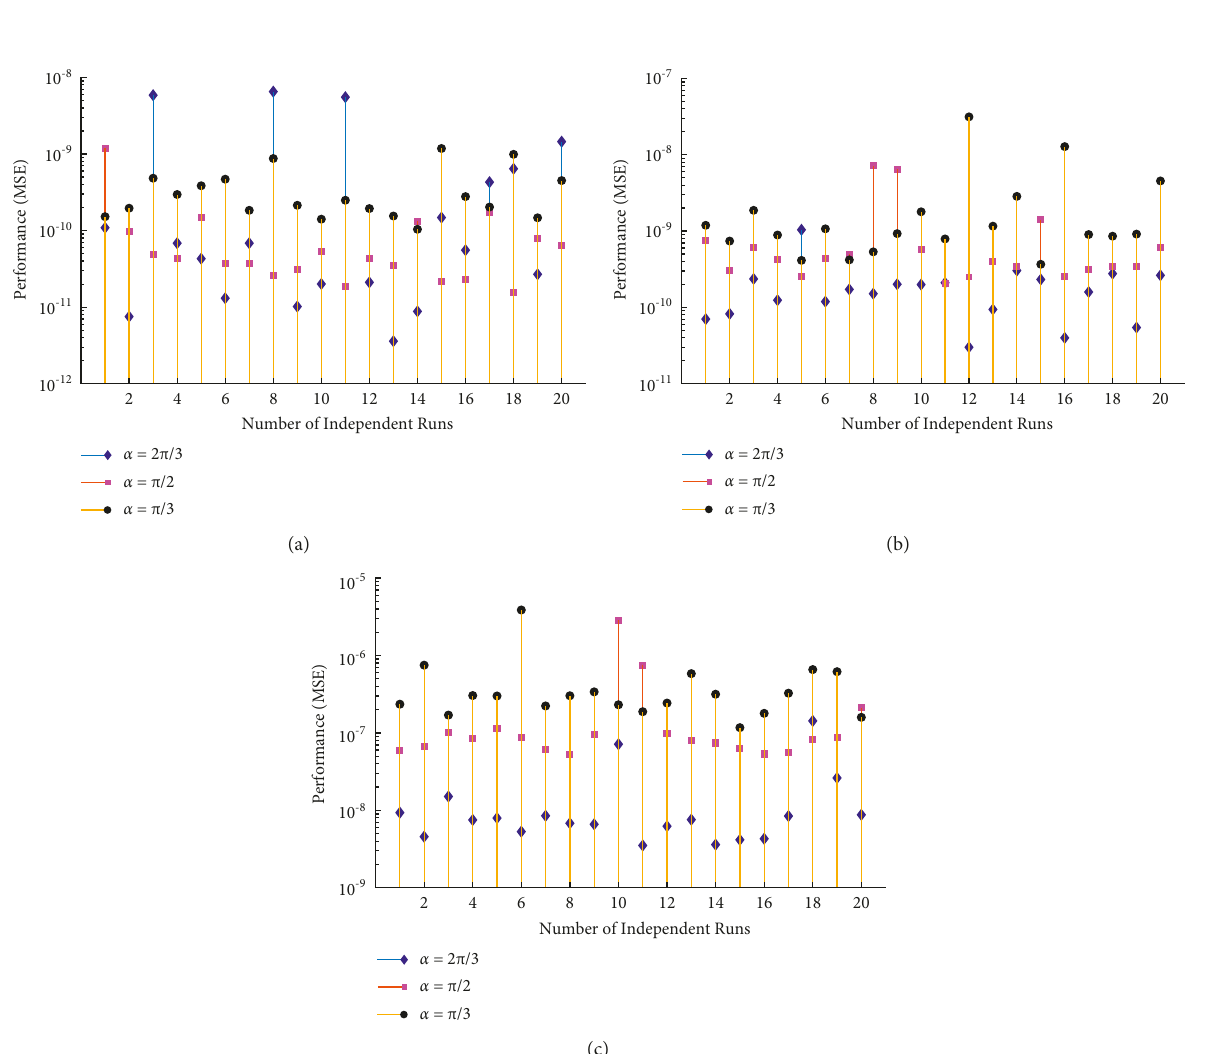
Figure 7: Values of performance function in terms of mean square error for different scenarios and cases of equation maximum values of absolute errors lie around 10 − 4 to 10 − 5 To study the smoothness of solutions, absolute errors for 1001 points are plotted in Figure 4. For scenario 1, the mean at t � 25 , 30 , 35 , 50 , 70 , 85 and 100. Similarly, the mean values of absolute errors lie around 10 − 6 to 10 − 9 while the absolute errors for scenario 2 and 3 lies around 10 − 5 to 10 − 8